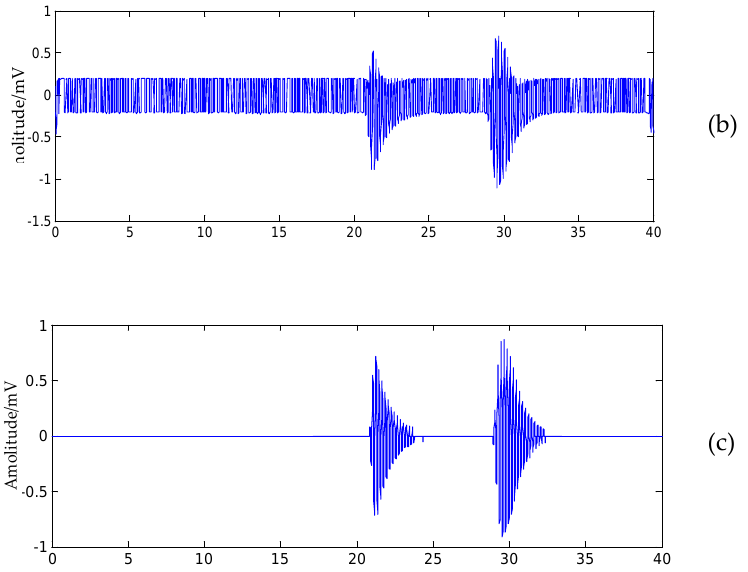
Figure 8. De-noising results by different methods. ( a ) Result of the CEEMD-based method. ( b ) Result of VMD—wavelet packet method. ( c ) Result of the proposed method.